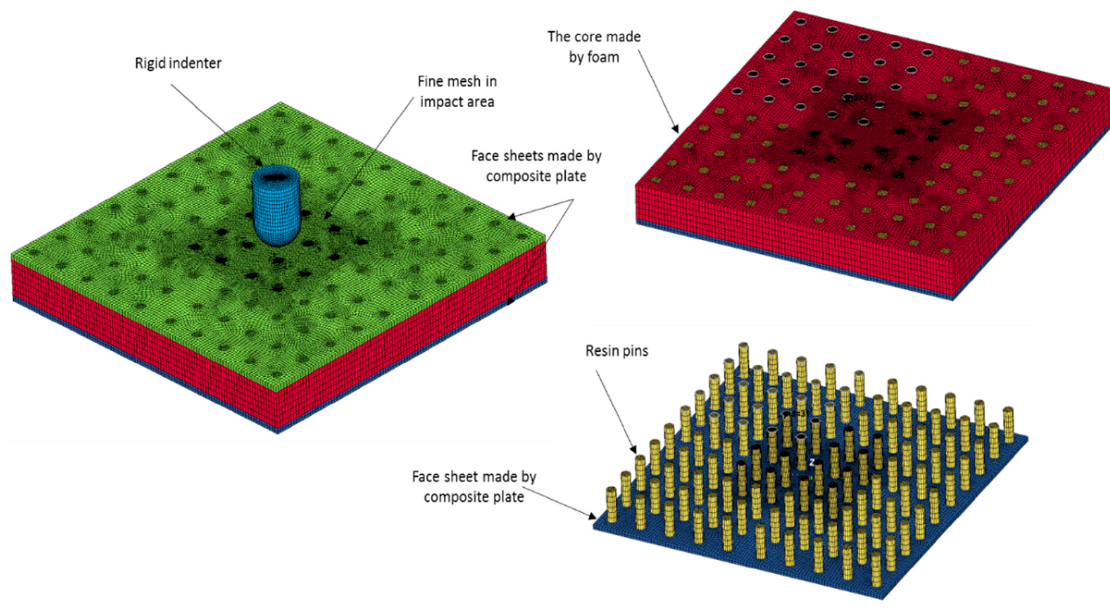
Figure 5. Presentation of FE model and detailed parts.